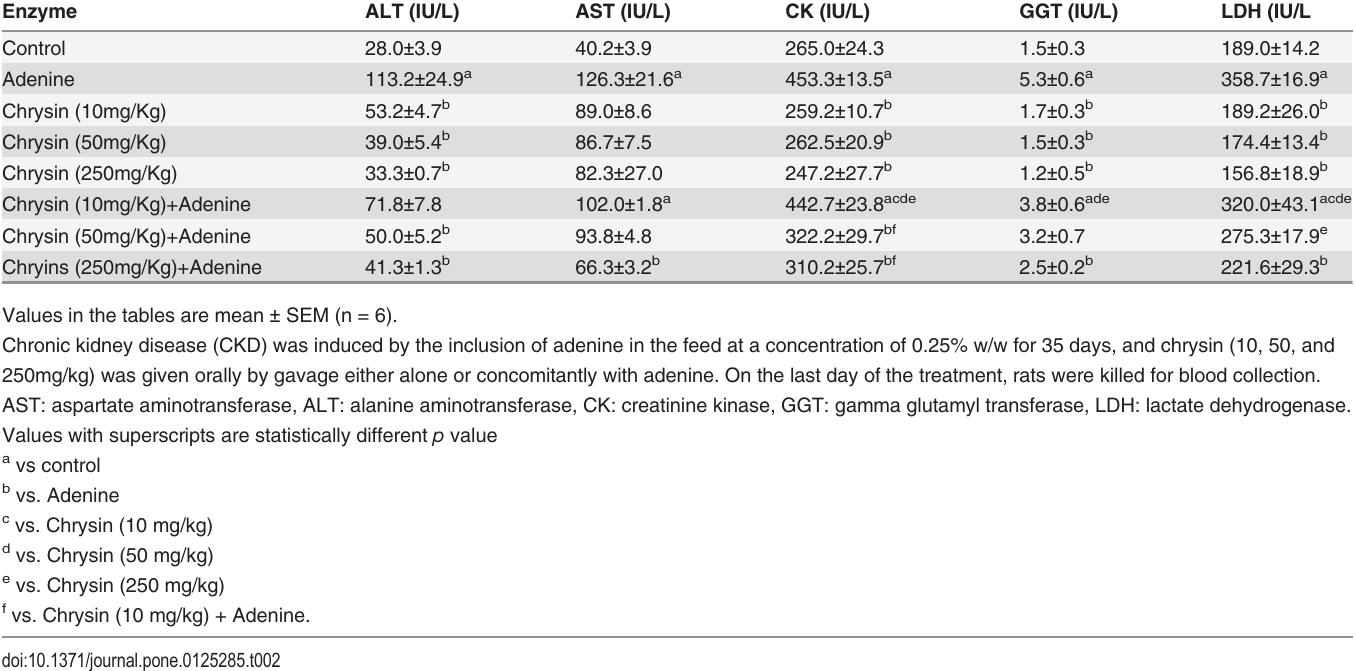
Table 2. Effect of chrysin on the activities of some enzymes in plasma rats with adenine-induced chronic kidney disease.